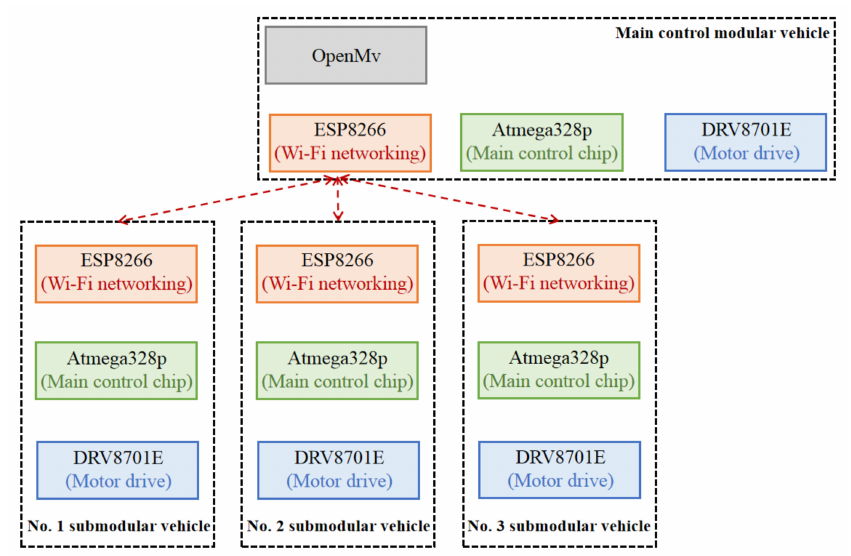
Figure 16. Schematic diagram of a hardware architecture for reconfigurable modular